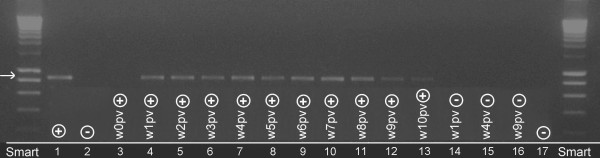
RT-PCR detection of mRNA in muscle tissue of vaccinated turkeys. Gel image representing the PCR results on cDNA, obtained from both vaccinated muscle tissue at the (presumed) site of injection from the day of vaccination (w0pv) to 10 weeks p.v. (lanes 3 to 13) and muscle tissue of the opposite (non-vaccinated) thigh on weeks 1, 4 and 9 p.v. (lanes 14 to 16). The SmartLadder (Eurogentec) was used as a molecular size marker (Smart). MilliQ water was used as a negative control (lanes 2 and 17) and cDNA, generated by RT-PCR from mRNA produced in vitro from pcDNA1::MOMP, as a positive control (lane 2). A band of 850 bp could be detected by gel electrophoresis from 1 to 10 weeks p.v. after PCR on cDNA from vaccinated muscle tissues, at the (presumed) site of injection (lanes 4 to 13). No PCR products were obtained after performing a PCR on cDNA from muscle tissue of the opposite (non-vaccinated) thighs (lanes 14 to 16) or muscle tissue at the site of injection at the day of vaccination (lane 3).